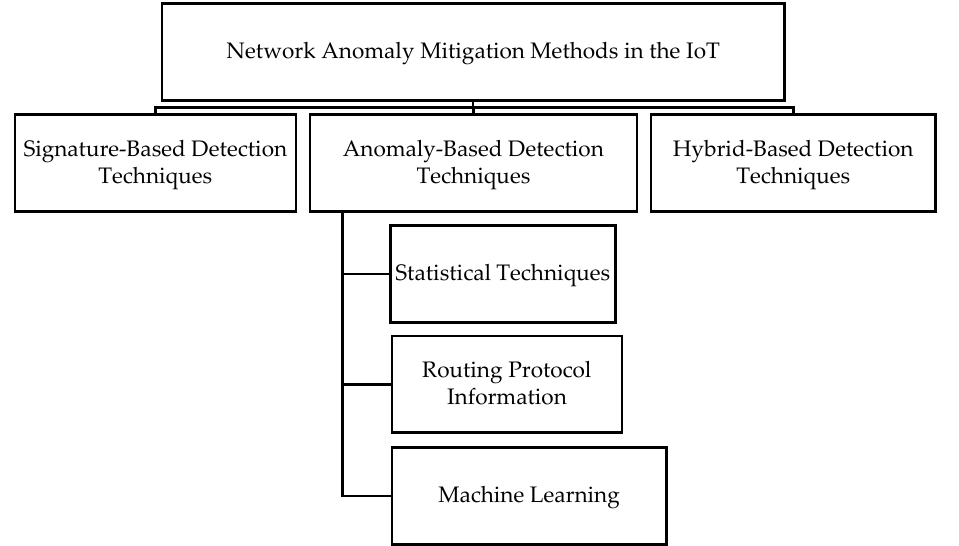
Figure 1. The classification of network anomaly mitigation methods in the IoT.